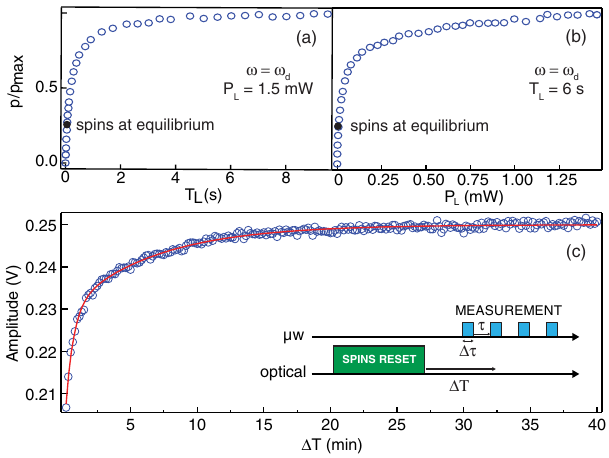
FIG. 3. Spin reset efficiency and relaxation. (a),(b) Relative spin polarization dependence on T L for P L ¼ 1 . 5 mW and on P L for T ¼ 6 s. The experimental sequence is shown in Fig. 2(c). (c) NV L spin relaxation time measurement. A series of Δ τ ¼ 20 ms weak microwave pulses ( − 120 dBm) at ω d = 2 π ¼ 2 . 884 GHz,separated by τ ¼ 10 s, is applied following optical reset of the spins. Blue dots are the average reflected amplitude of each pulse. A biexpo- nential fit (red solid line) yields T 1 ;a ¼ 35 s and T 1 ;b ¼ 395